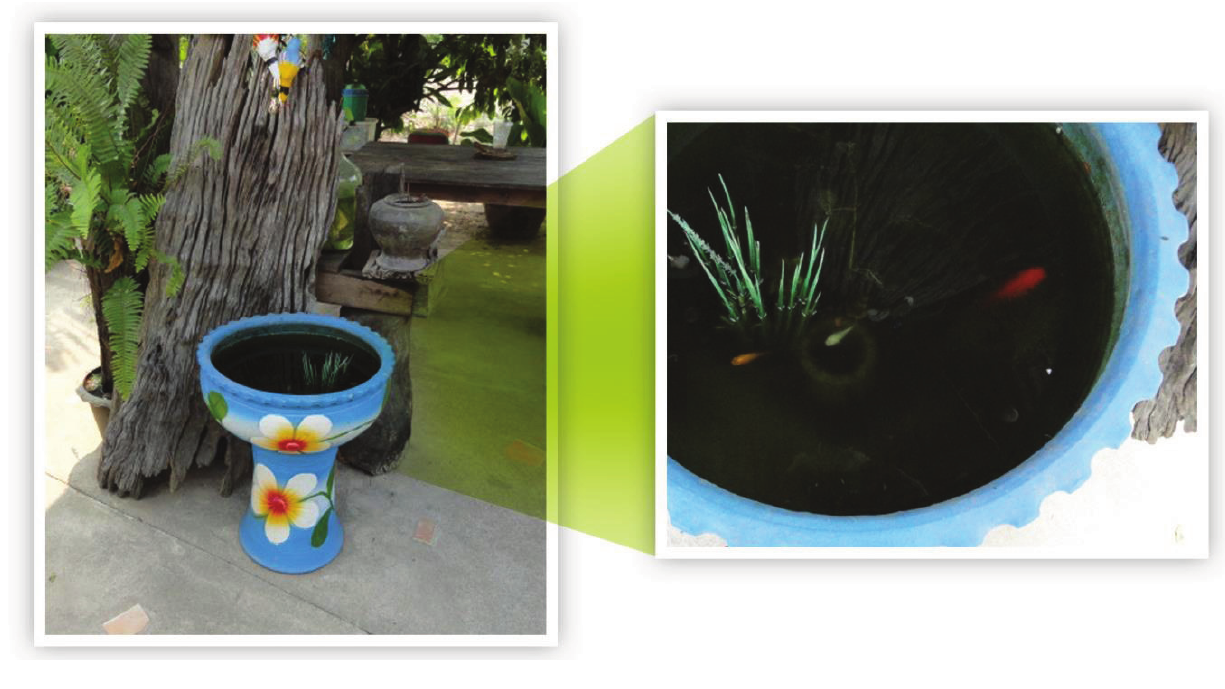
Figure 2. Larvivorous fish. Source: Pattamaporn Kittayapong and Phanthip Olanratmanee,